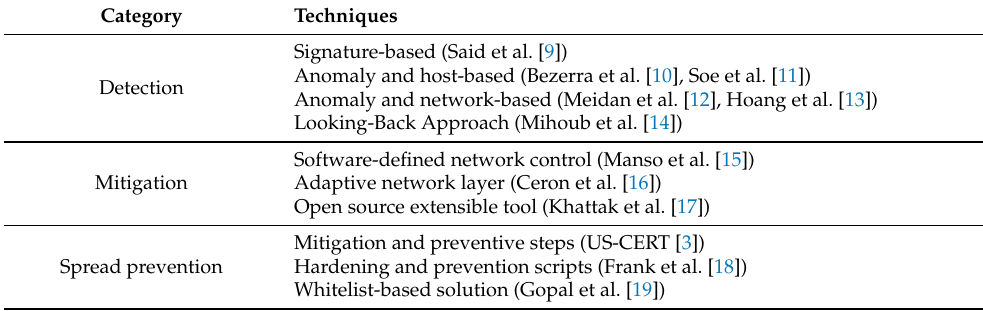
Figure 1. Countermeasure techniques against malicious botnet threats. Table 1. Countermeasure